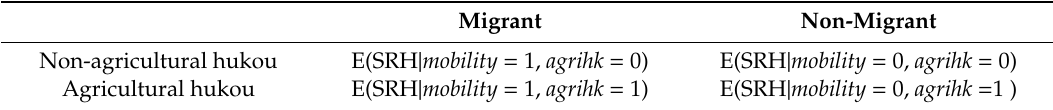
Table 3. The Di ff erence-in-Di ff erence construction.